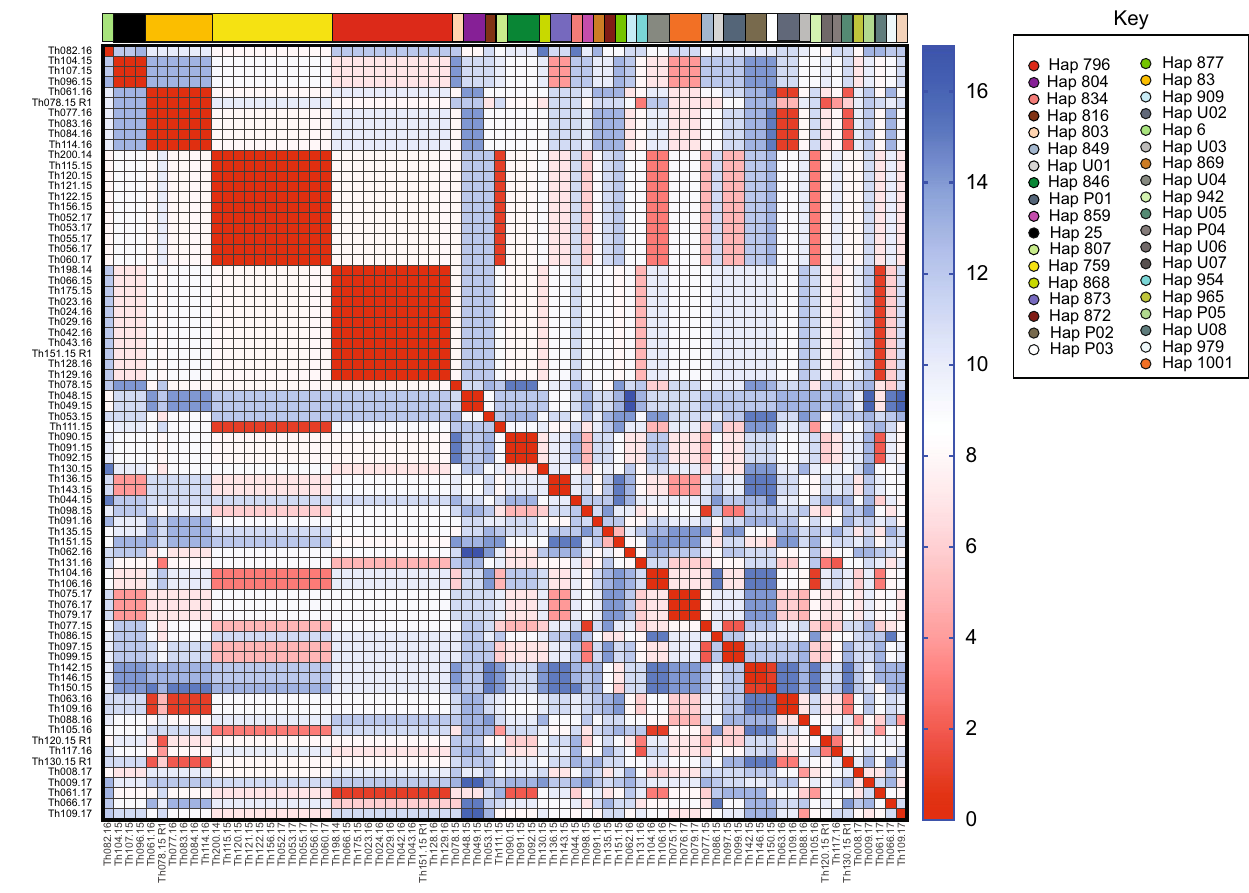
Figure 2. Heatmap illustrating parasite genetic barcode similarity. Sample IDs are listed on the vertical axis and barcodes are clustered by genetic similarity. Barcode haplotypes are color coded at the top of the heatmap and in the Key. Heatmap scale (right) shows the number of barcode SNP differences and range from identical (fewest differences; red) to greatest differences (blue). The maximal number of differences possible is